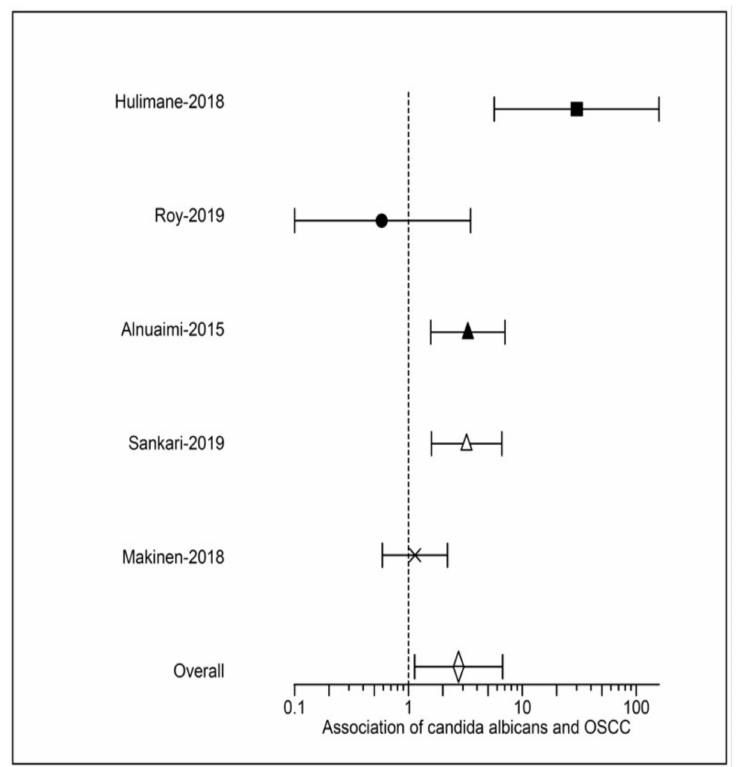
Figure 3. Forest plot summarizing the results of the meta-analysis for CA and OSCC.